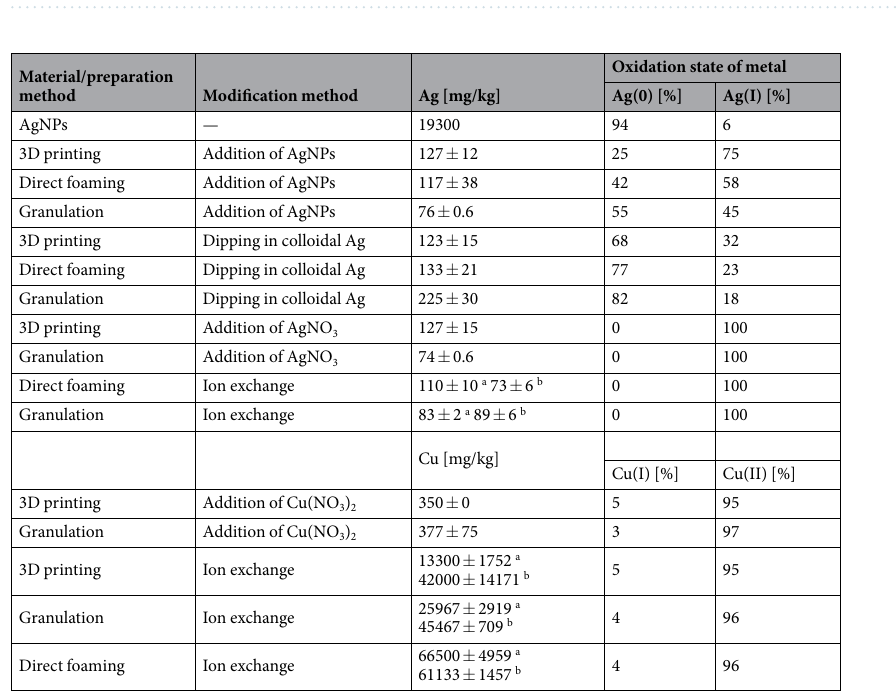
Figure 8. Morphological characterization of a geopolymer granule with X-ray microtomography and SEM. The green part represents the porous surface layer and the gray part represents the dense core.